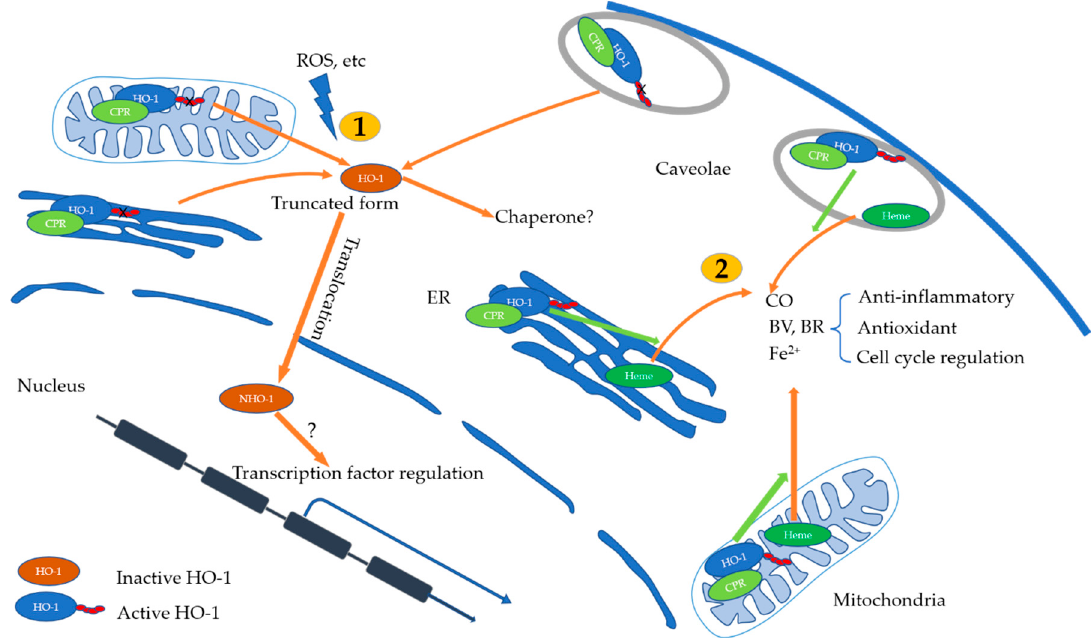
Figure 2. Subcellular localization and roles of HO-1. 1. HO-1 locates in endoplasmic reticulum (ER), mitochondria, plasma membrane, and the caveolae. HO-1 is fixed on the membrane by a transmembrane sequence (TMS) and stabilized by cytochrome P450 reductase (CPR) to prevent relocation. It remains full protein structure and enzymatic activity and its function is achieved mainly through enzymatic activity. Its enzymatic products CO, BV, and BR have been shown to have anti-inflammatory, antioxidant, cell cycle regulation properties; 2. HO-1 will be truncated and relocated under pathological conditions or external stimuli which leads to cellular stress. Truncated HO-1 lacks enzyme activity to degrade heme and may act as a chaperone to regulate the activity of signaling pathway proteins or as a transcription factor regulator.